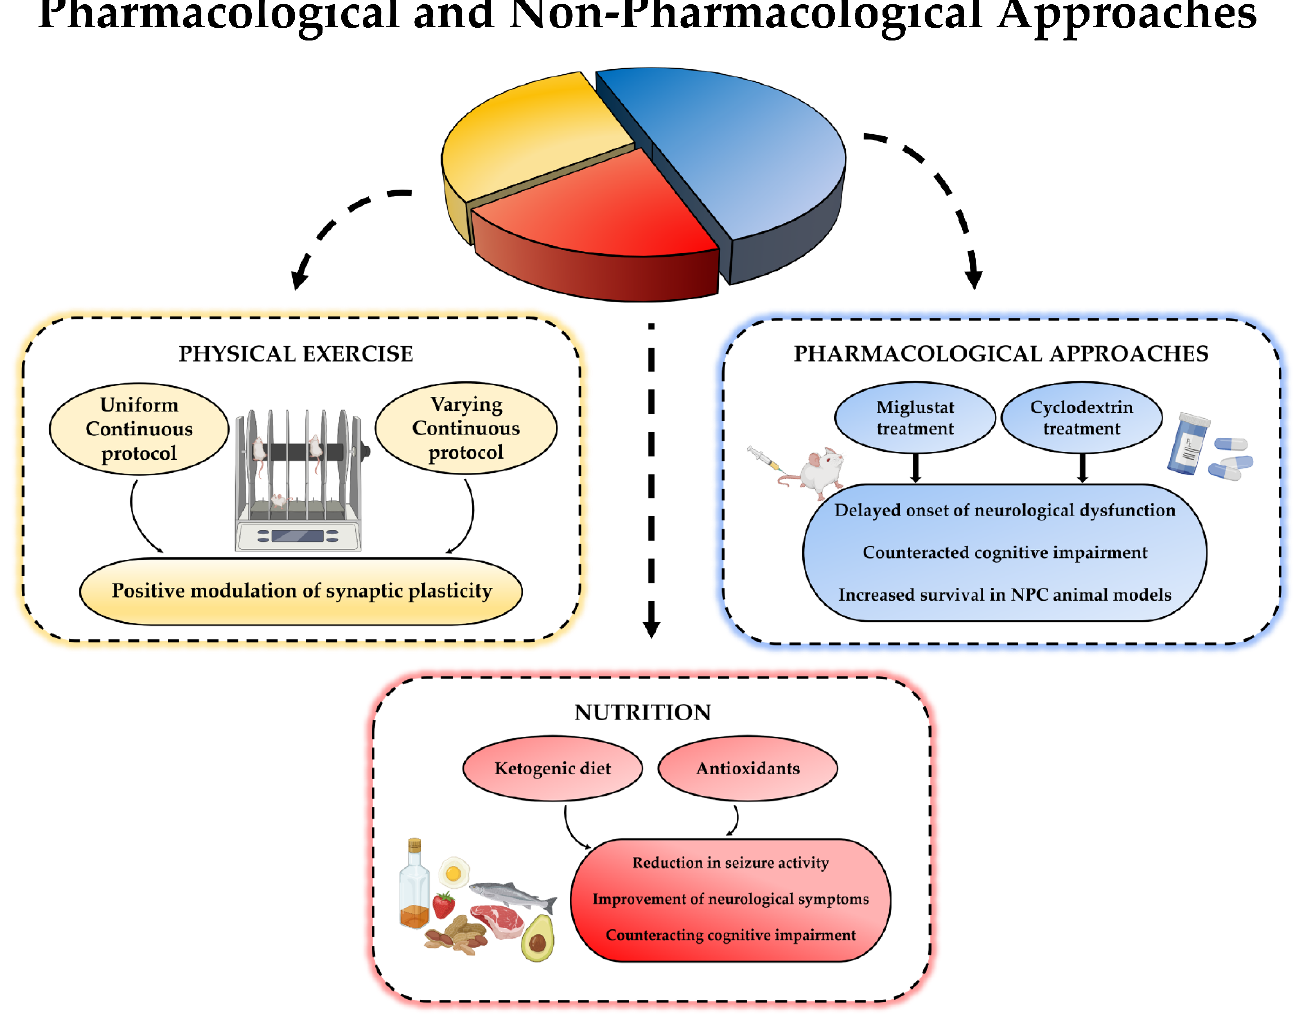
Figure 4. A schematic image of the combination between pharmacologic and non-pharmacologic approaches for NPC disease.